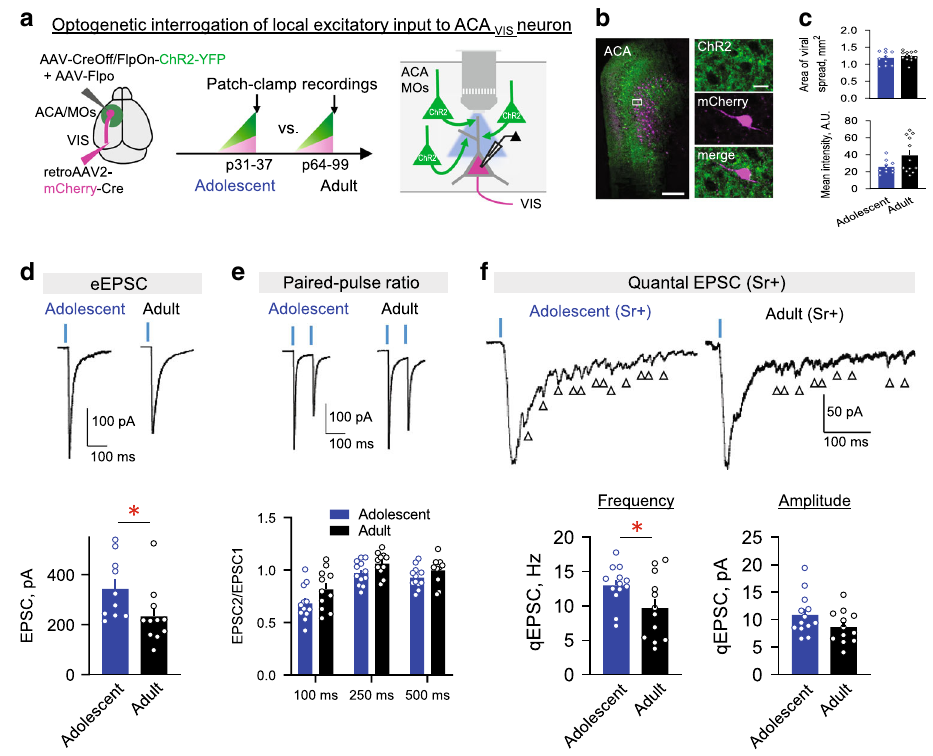
Fig. 3 Greater adolescent local excitatory synaptic inputs onto ACA VIS neurons. a Schematic of intersectional viral approach to test local excitatory synaptic input speci fi cally onto ACA VIS projection neurons in adolescence and adulthood. (Left) Injections of retrograde AAV2-mCherry-Cre into the VIS labeled ACA VIS projection neurons in ACA with red fl uorescence, while injections of AAV-Flpo and AAV-CreOff/FlpOn-ChR2-YFP into ACA enable ChR2- YFP expression in all but ACA VIS projection neurons. (middle) AAV injections were done at p12.8 ± 0.5 in average (p11 – 15) for Adolescent group and at p43.0 ± 1.9 in average (p38 – 58) for Adult group. Slice patch clamp recordings were performed at p33.5 ± 0.7 in average (p31 – 37) for Adolescent group and at p71.8 ± 4.2 in average (p64 – 99) for Adult group. (right) Local inputs were stimulated in situ by activating ChR2 using wide- fi eld LED. b (Left) Labeling of local inputs (green) and ACA VIS projection neurons (magenta) in ACA. (Right) High magni fi cation of boxed area showing mCherry + ACA VIS neuron does not express ChR2-YFP and is surrounded by ChR2 + YFP terminals. Scale bars: 200 μ m on the left and 20 μ m on the right. Experimental images were obtained from 17 mice with similar results obtained. c Quanti fi cation of the spread and intensity of the YFP signal shows no signi fi cant differences between Adolescent and Adult groups (area: two-tailed unpaired t -test, t 20 = 0.756, P = 0.4585, mean intensity: two-tailed unpaired t -test, t 20 = 1.936, P = 0.0672, n = 11 slices from 10 biologically independent mice for adolescent and n = 12 slices from 7 biologically independent mice for adult groups). d Light-evoked monosynaptic EPSC traces (top) and mean amplitude (bottom) for two developmental age groups (two-tailed unpaired t -test, t 19 = 2.122, * P = 0.0472, n = 10 cells from fi ve biologically independent mice for adolescent and n = 11 cells from six biologically independent mice for adult groups). Blue dashes indicate the time of light stimulation. e Short-term dynamics of local synaptic inputs onto ACA VIS neurons. Representative EPSC evoked by pair of light stimuli (top) and average paired pulse ratio (bottom) (EPSC2/EPSC1 Adolescent vs. EPSC2/EPSC1 Adult, two-way ANOVA, time × age interaction: F 2 ,63 = 0.3418, P = 0.7118, n = 12 cells from four biologically independent mice for adolescent and n = 11 cells from four biologically independent mice for adult). f Examples of light-evoked quantal EPSC (qEPSC) in ACA VIS neurons in the presence of strontium (top) to produce delayed asynchronous quantal release of neurotransmitters. Arrows indicate detected qEPSCs. (bottom) Averaged qEPSC frequency (left) and amplitude (right) for Adolescent and Adult groups (two-tailed unpaired t -test, frequency: t 23 = 2.118, * P = 0.0452, amplitude: t 23 = 1.626, P = 0.12, n = 13 cells from four biologically independent mice for adolescent and n = 12 cells from 5 biologically independent mice for adult). Data in c – f are presented as mean ± s.e.m. Source data are provided as a Source data fi